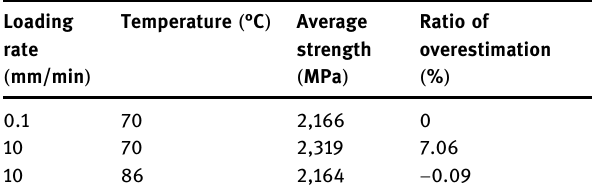
Table 2: Strength comparison of di ff erent loading conditions